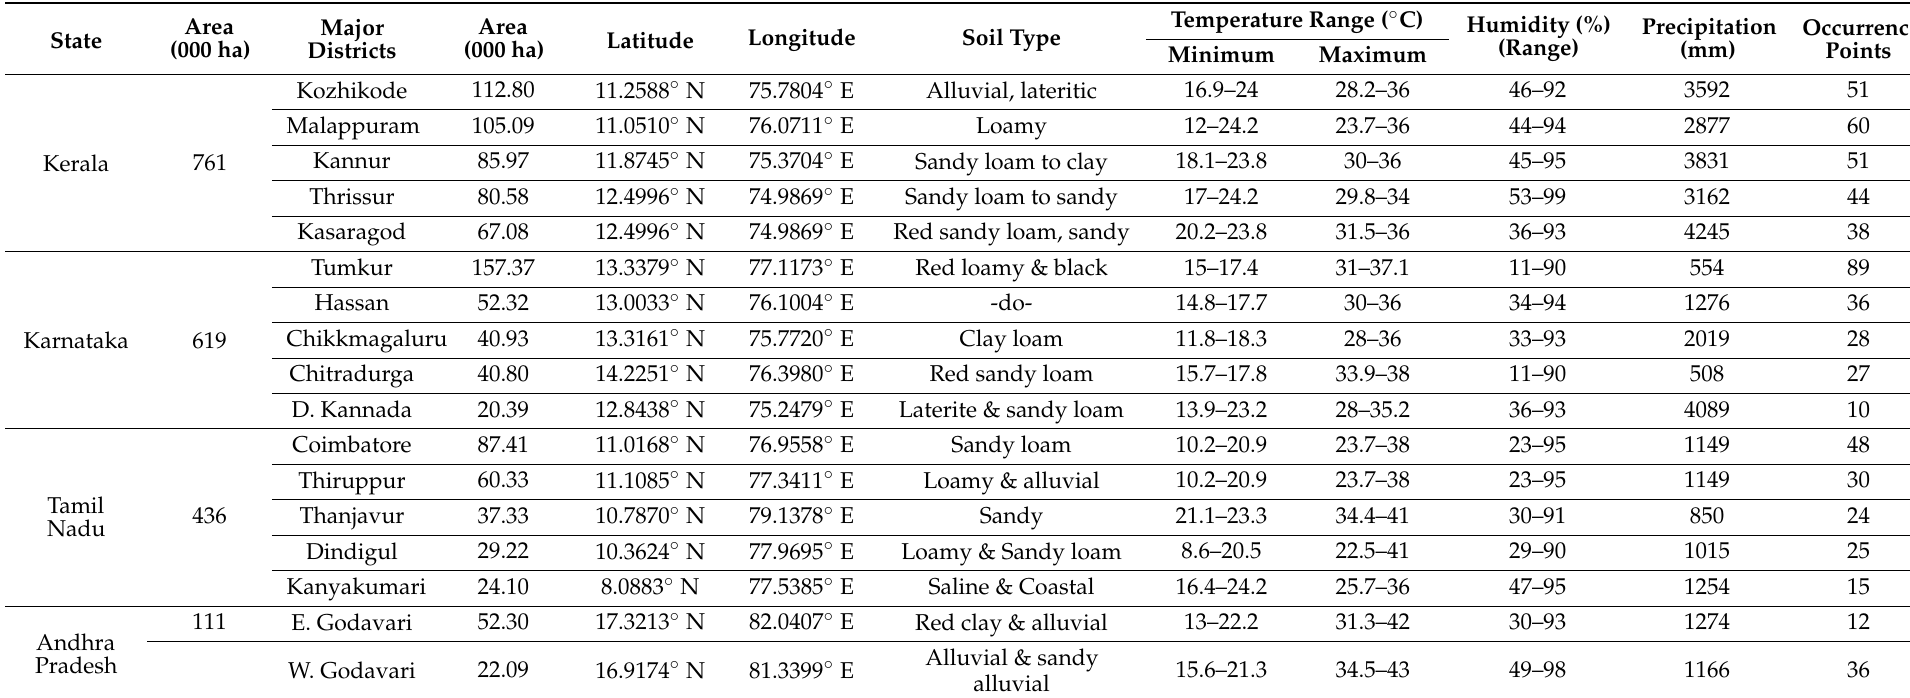
Table 1. Characteristics of some of the major coconut growing districts of India from which the occurrence data was collected as input to MaxEnt model. Humidity is the range shown for the summer months (March, April, and May). Occurrence points are the number of points for each location after model